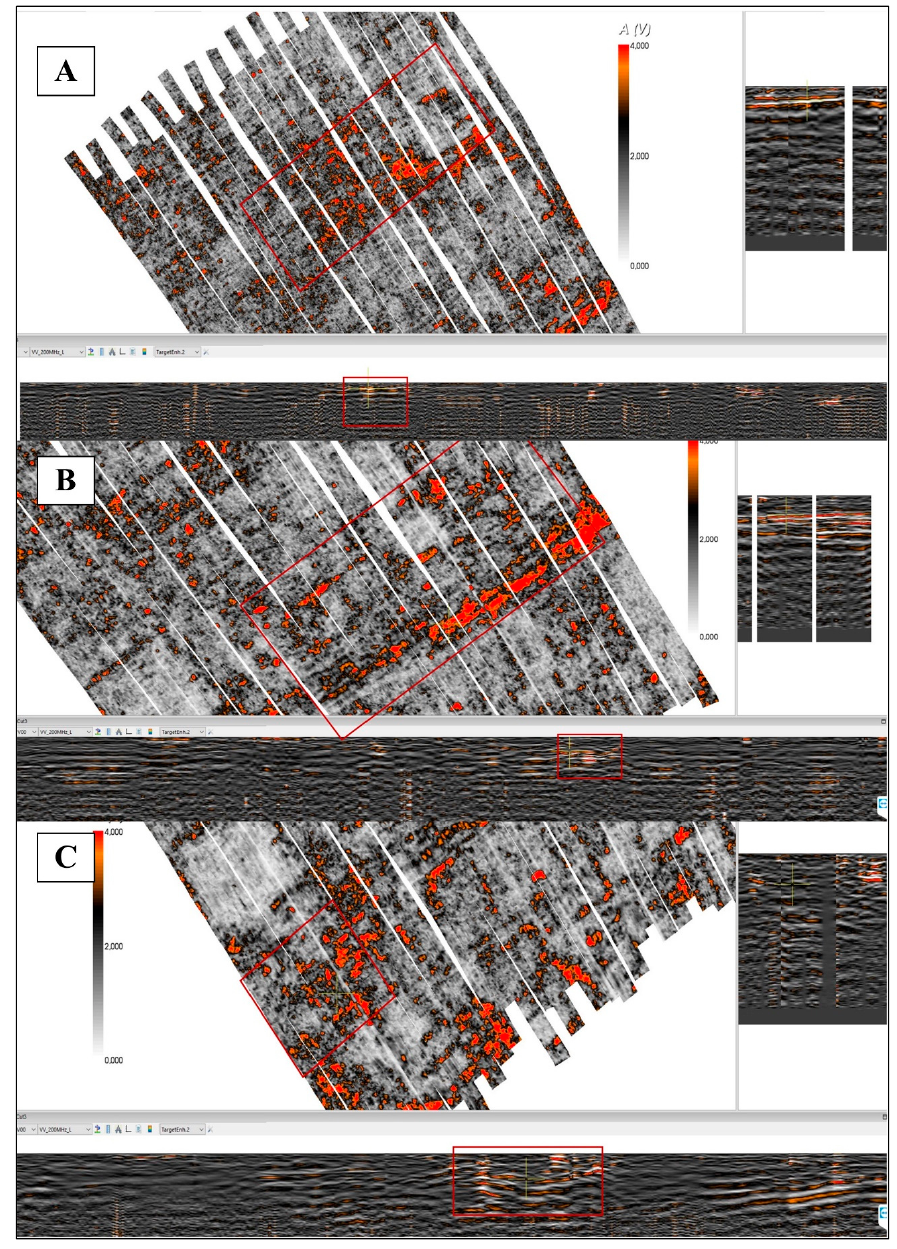
Figure 8. Main alterations to project 3 in GRED HD: ( A ) P3-1; ( B ) P3-2; ( C ) P3-3.